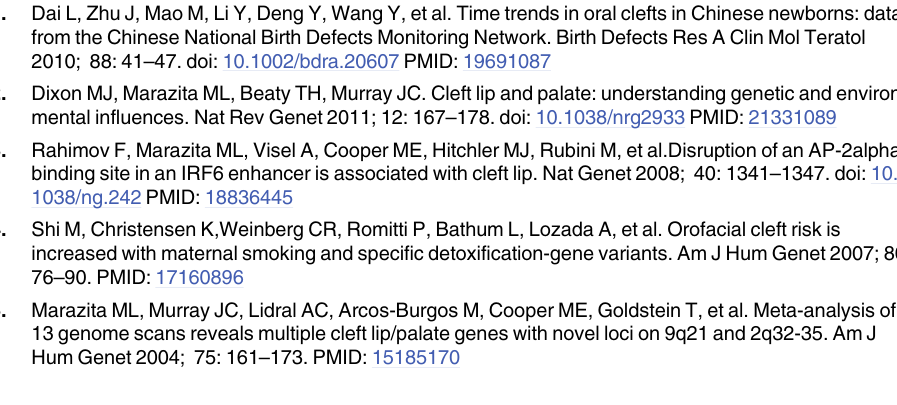
(JPG) (JPG) S1 Table. Genotype counts for rs2486668 and rs545809 in the sample set.